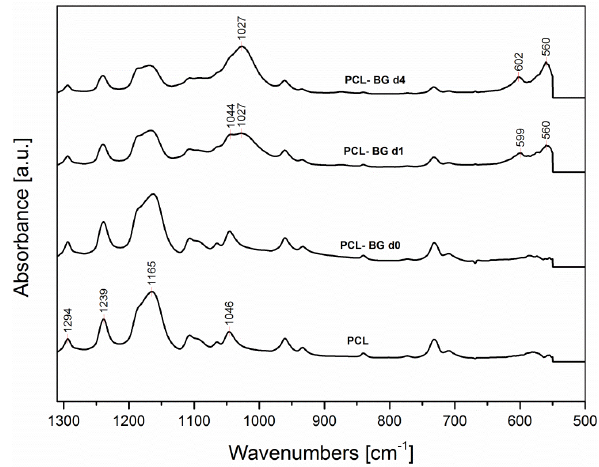
Figure 10. FTIR spectra in the range 1300–500 cm −1 for electrospun samples of neat PCL (PCL), PCL with BG particles before immersion in SBF solution (PCL-BG d0) and after one day (PCL-BG d1) and four days (PCL-BG d4) of immersion in SBF solution (the characteristic peaks are discussed in the text).